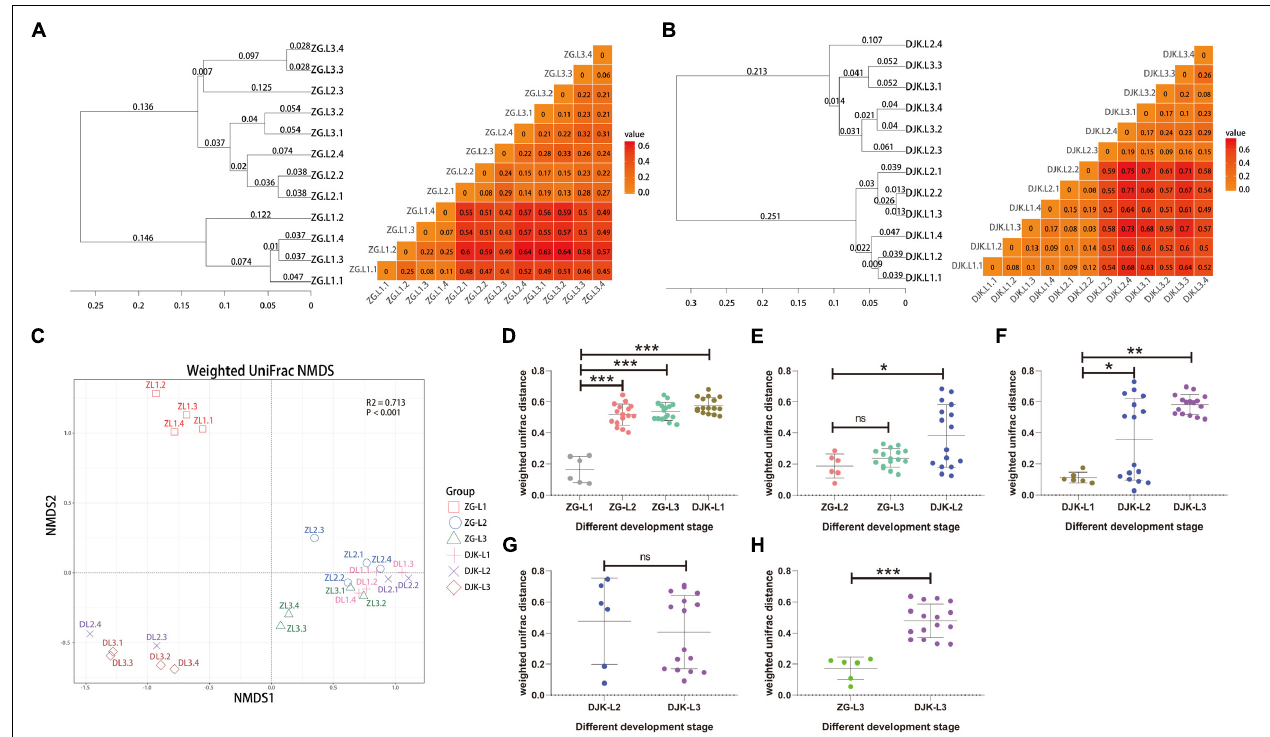
FIGURE 4 | Bacterial community dissimilarity of two field populations based on UniFrac metrics. (A) UPGMA (left) and heatmap (right) analyses of the bacterial community in the ZG population. (B) UPGMA (left) and heatmap (right) analyses of the bacterial community in the DJK population. (C) NMDS analyses of all samples. Each symbol represents a sample, and different colors represent the different development stages of larvae. Variation in communities segregated strongly according to host developmental stage and different field populations (PERMANOVA test with 999 permutations, P ≤ 0.001). (D–H) Weighted UniFrac distances between different development stages ( n = 6 ∼ 16). In each panel, the first entry in the X axis serves as the reference for the comparisons, and the median is plotted as the horizontal line. ∗ p < 0.05; ∗∗ p < 0.01; and ∗∗∗ p < 0.001; ns, not significant as calculated by Student’s t